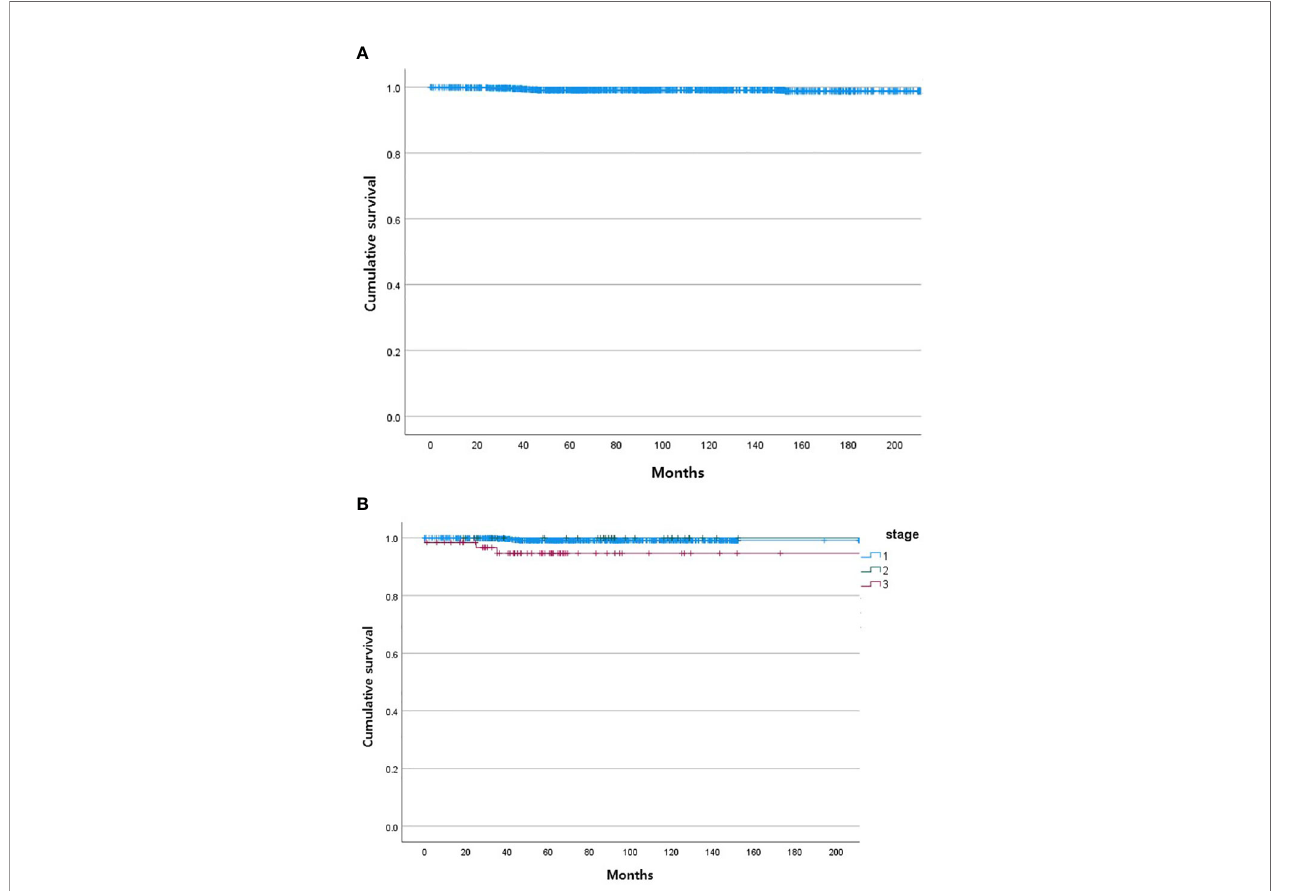
FIGURE 2 | Kaplan Meier curves of gastric MALT lymphoma patient survival. (A) Total. (B) According to stage of gastric MALT lymphoma (stage I, stage II, stage